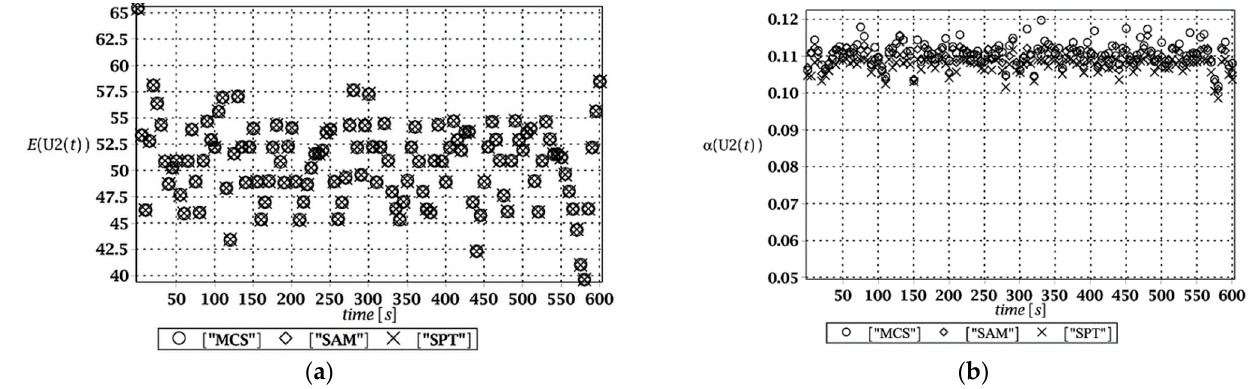
Figure 4. ( a ) The expectation of vertical displacement at the ridge of frame for random thickness; ( b ) its coefficient of variation.